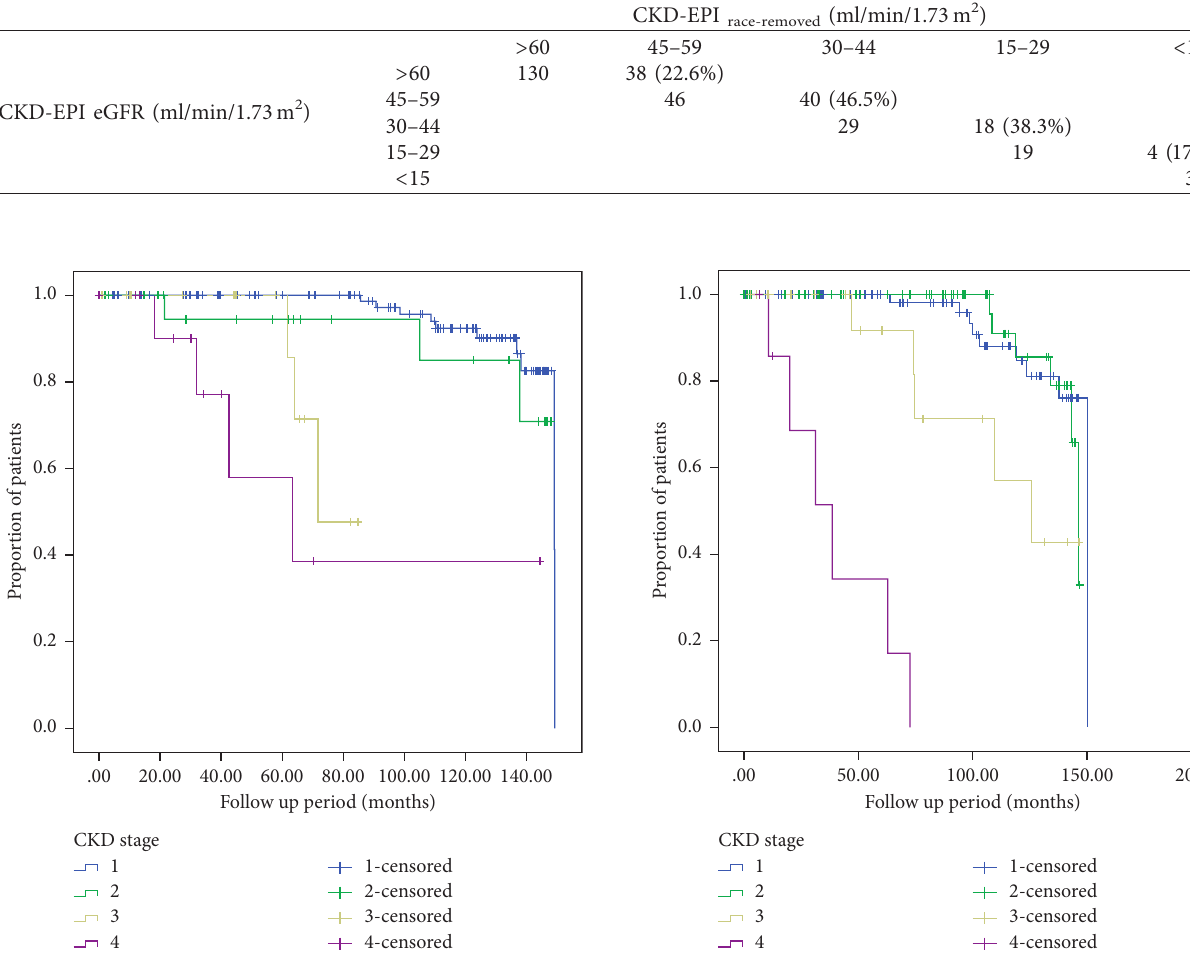
Table 5: Comparison between the CKD-EPI and CKD-EPI